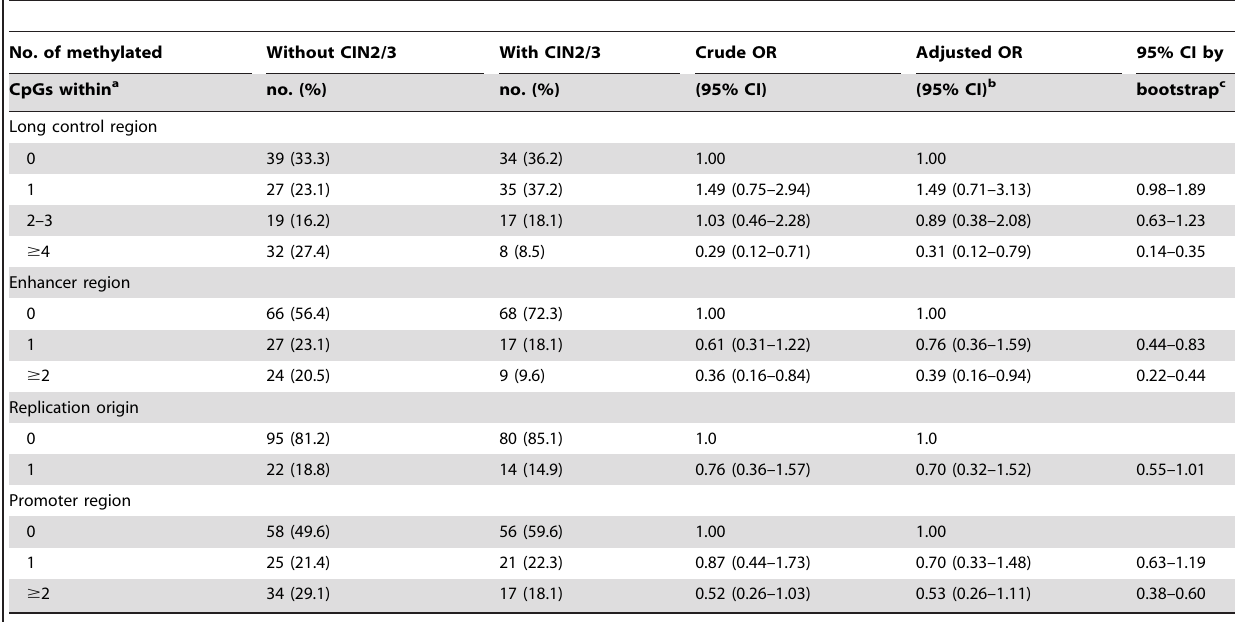
Table 2. Odds ratios and 95% confidence intervals for the association of CIN2/3 with number of methylated CpGs in the regions analyzed.